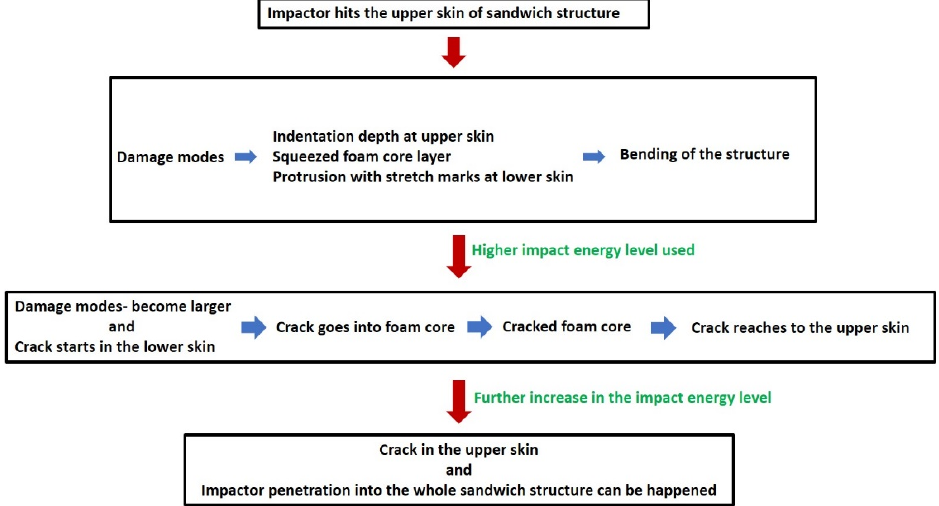
Figure 7. Damage progression mechanism of rotationally moulded sandwich structure during a low-velocity impact (LVI) event.